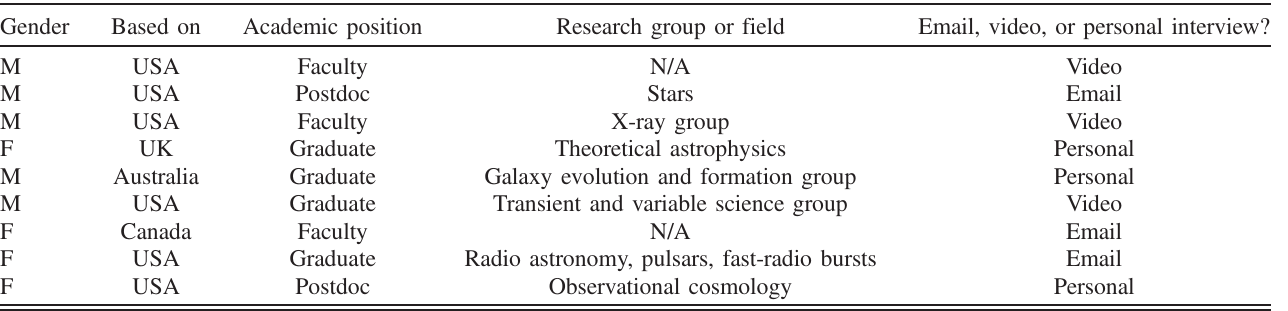
TABLE II. Characteristics of the 9 participants who had a follow-up interview with us.